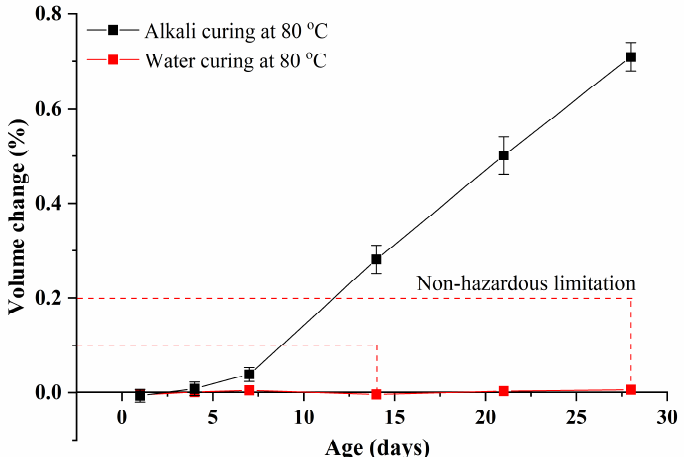
Figure 6. Volume changes of the sample Control 0.41 under alkali curing at 80 °C and water curing at 80 °C.